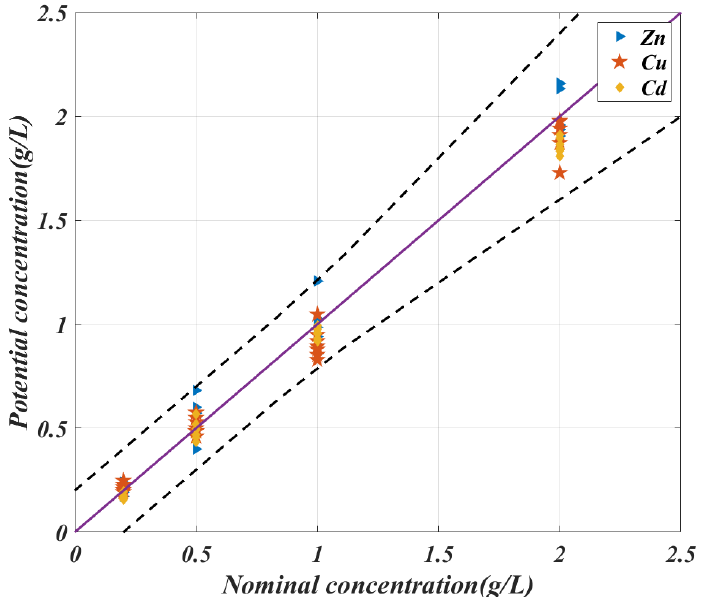
Figure 10. The set of multiple concentration predictions for all solutions. The horizontal axis is the calibrated concentration, and the vertical axis is the predicted concentration. The dashed line represents an error of more than ±20% or ±200 mg/L.